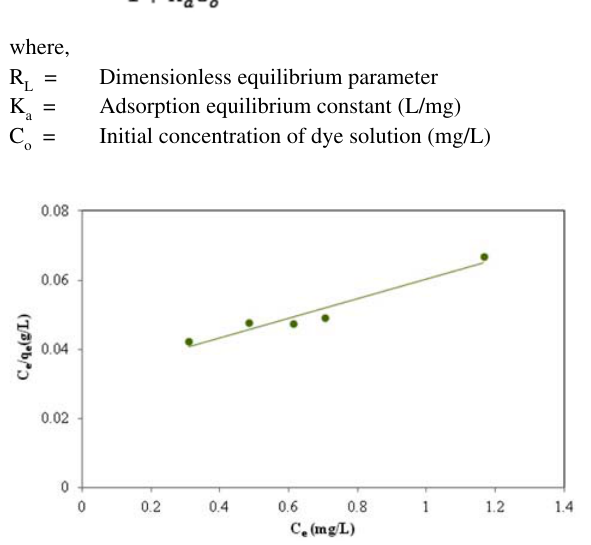
Figure 11. Langmuir isotherm of MG